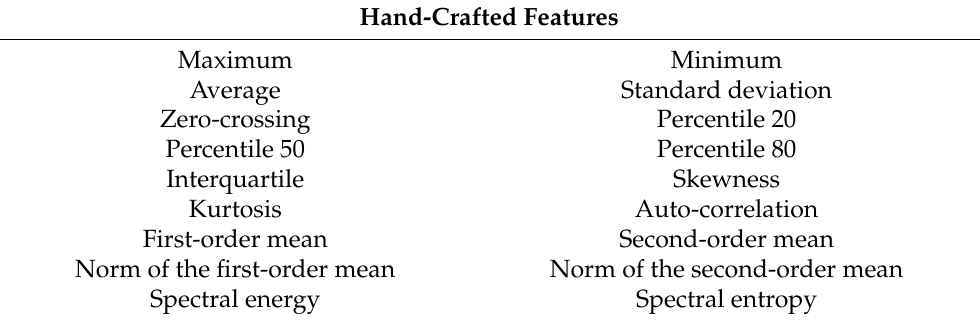
Table 2. Hand-crafted features calculated independently for each sensor